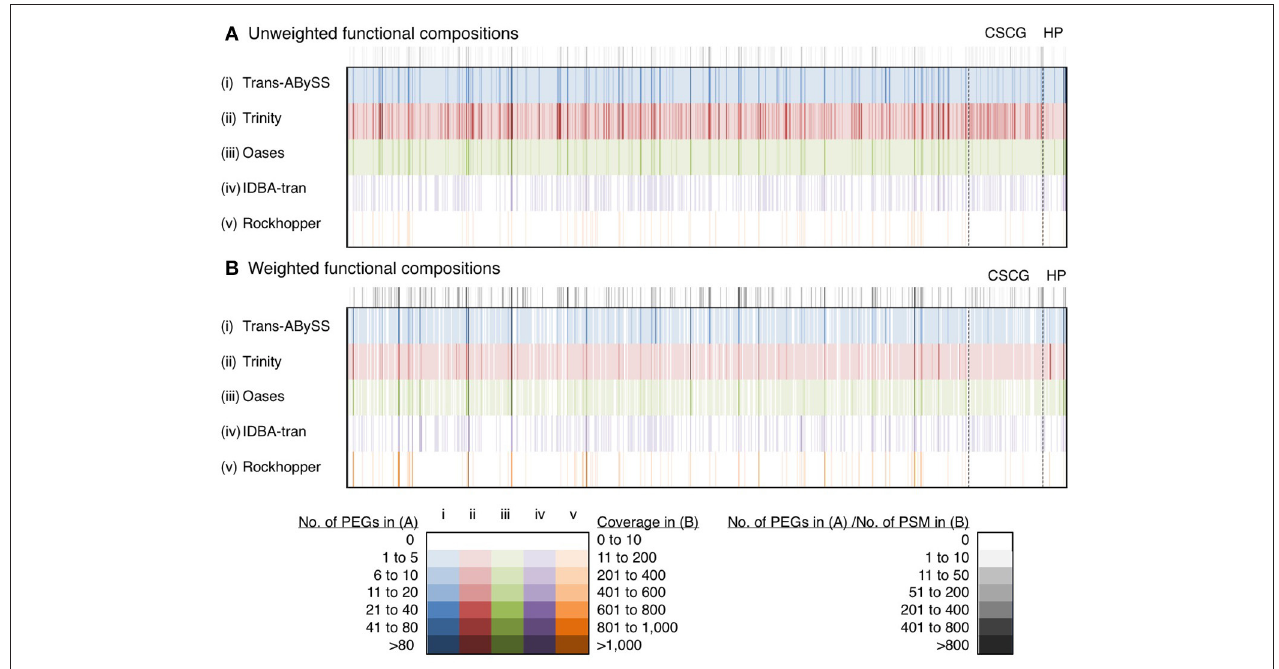
FIGURE 8 | Unweighted and weighted functional diversity profiles of 863 protein IDs. These 863 protein IDs, represented by the color bars, were shared by Trans-ABySS, Trinity and Oases cRNA assemblies. Color intensity indicates the number of protein-encoding genes (PEGs) and coverage (read counts mapped to the parent transcript, then normalized to transcript length) in (A) unweighted and (B) weighted profiles. Gray scale indicates the number of PEGs and number of peptide-spectral matches (PSM) detected in the metaproteome that were mapped to the (A) unweighted and (B) weighted profiles, respectively. Abbreviations: CSCG, conserved single-copy gene; HP, hypothetical protein. The data is provided in Table